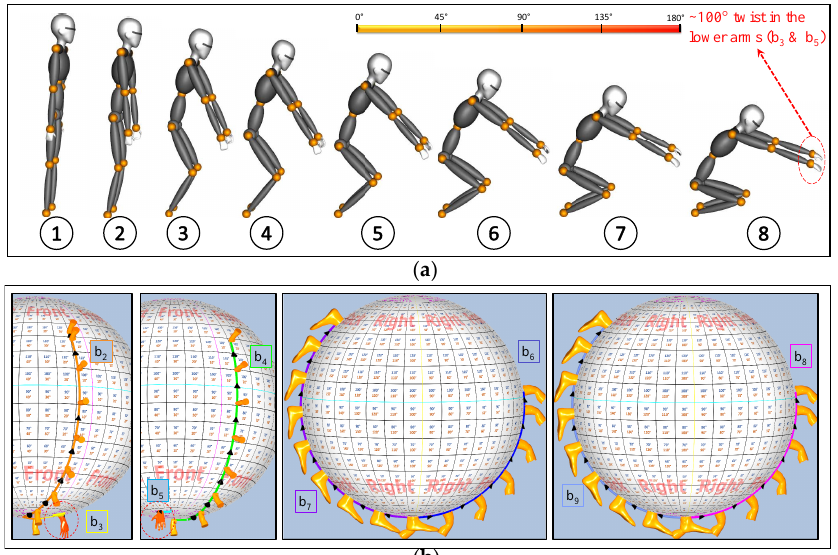
Figure 18. ( a ) Eight key frames authored using the Motion-sphere by editing the points on the unit sphere and three-dimensional (3D) reconstruction on a virtual avatar. ( b ) Visualization of full body trajectory for squat movement authored using a